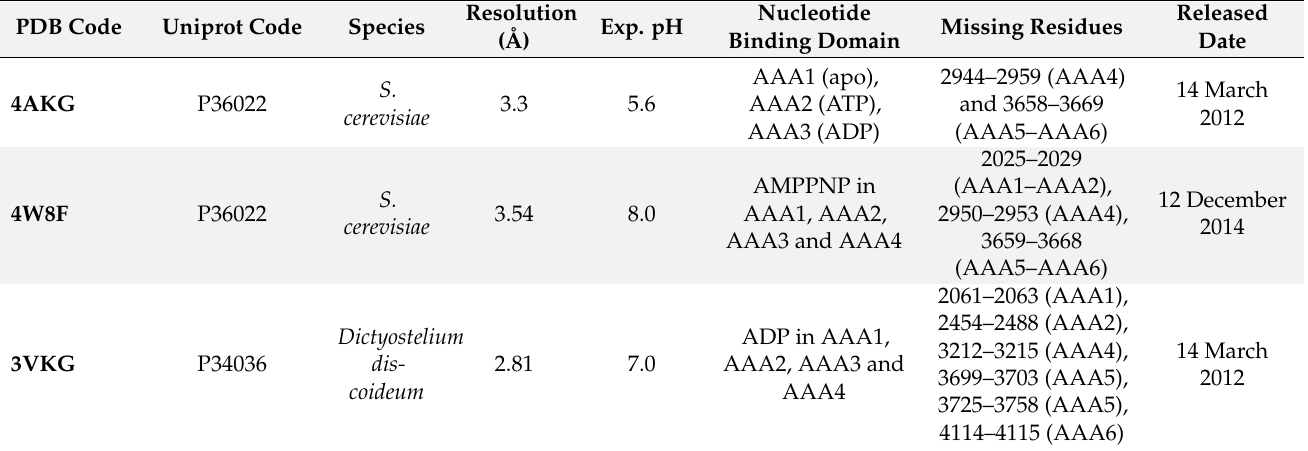
Table 1. Summary of the features of the crystallographically solved structures of dynein used in this study. PDB Code